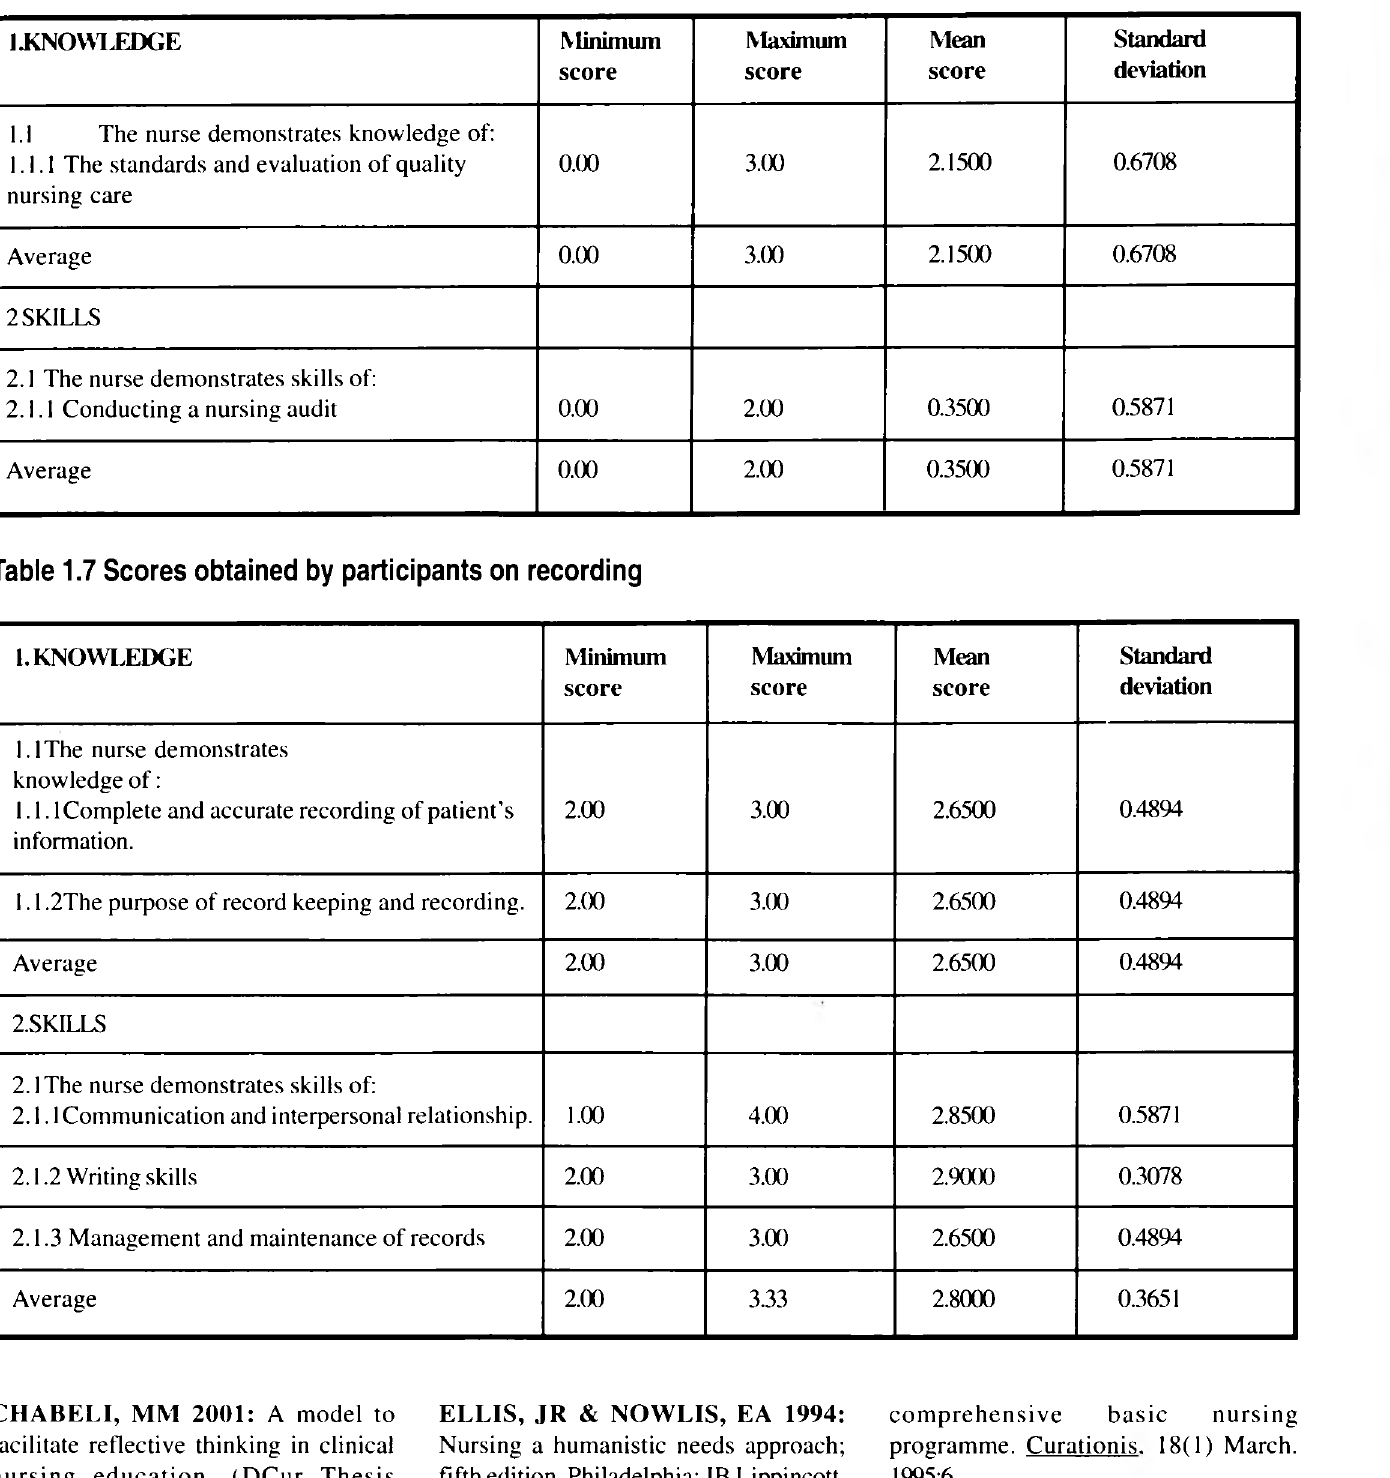
Table 1.7 Scores obtained by participants on